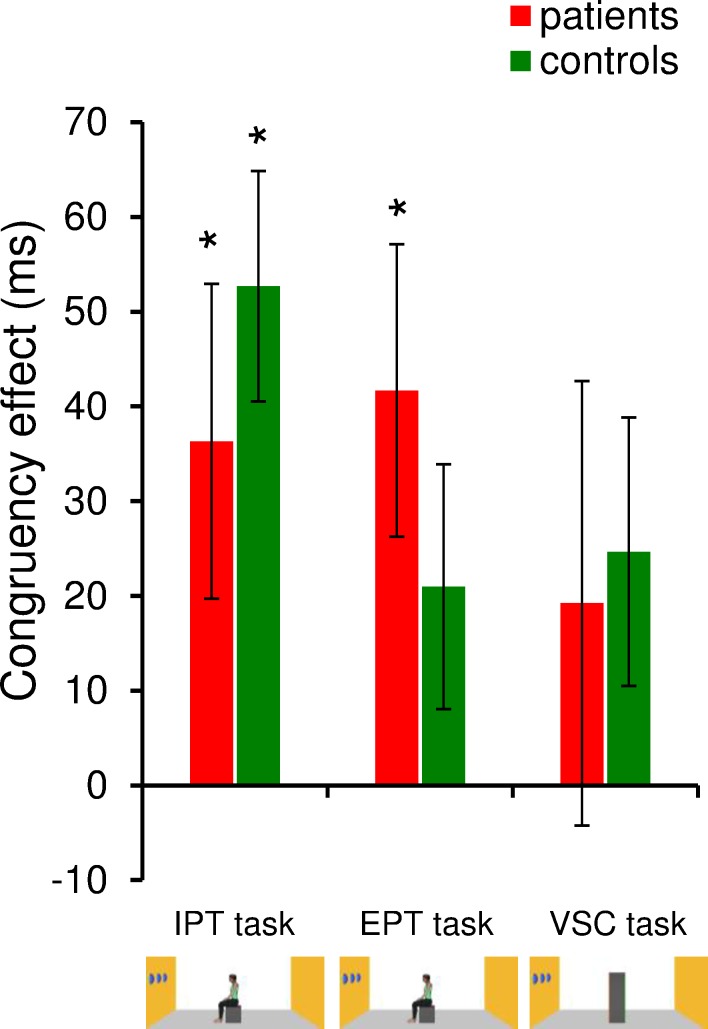
Results for the visuo-spatial perspective-taking tasks (Experiment 1; Congruency effects).Histograms represent the average congruency effect (incongruent viewpoint minus congruent viewpoint) calculated for the implicit perspective-taking (IPT) task, explicit perspective-taking (EPT) task, and visuo-spatial control (VSC) task for patients and controls. * indicates significant differences with respect to zero (t-test). Vertical bars represent the standard error of the mean.